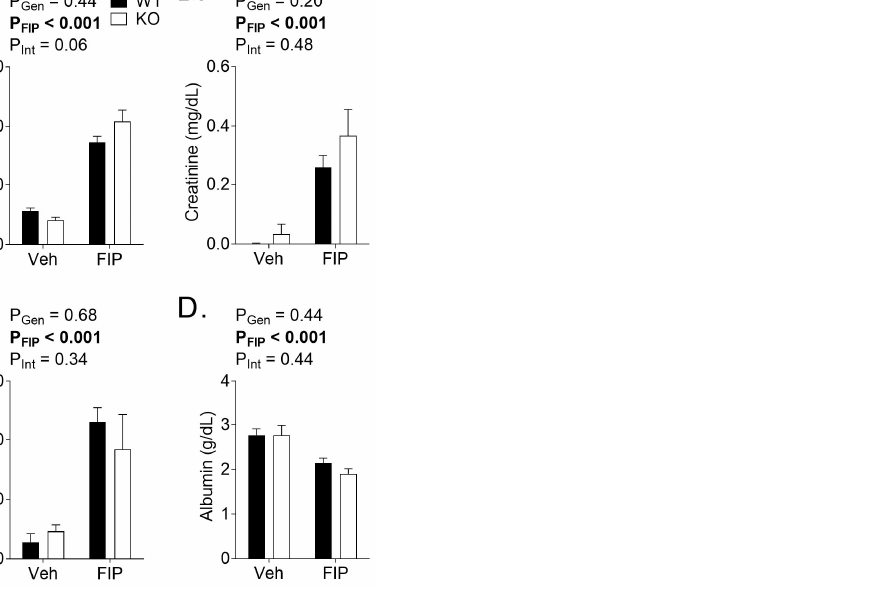
Figure 2. Serum biochemistry in wild-type (WT) and OSMR type II receptor knockout (KO) mice subjected to fecal slurry (FS)-induced peritonitis (FIP) or treated with vehicle (Veh). Serum collected 18 h post-injection of Veh or FS was analyzed for the levels of ( A ) blood urea nitrogen (BUN), ( B ) creatinine, ( C ) alanine aminotransferase (ALT), and ( D ) albumin. p values reflect the outcomes of 2-way analysis of variance. Each bar represents n = 3–5 mice.